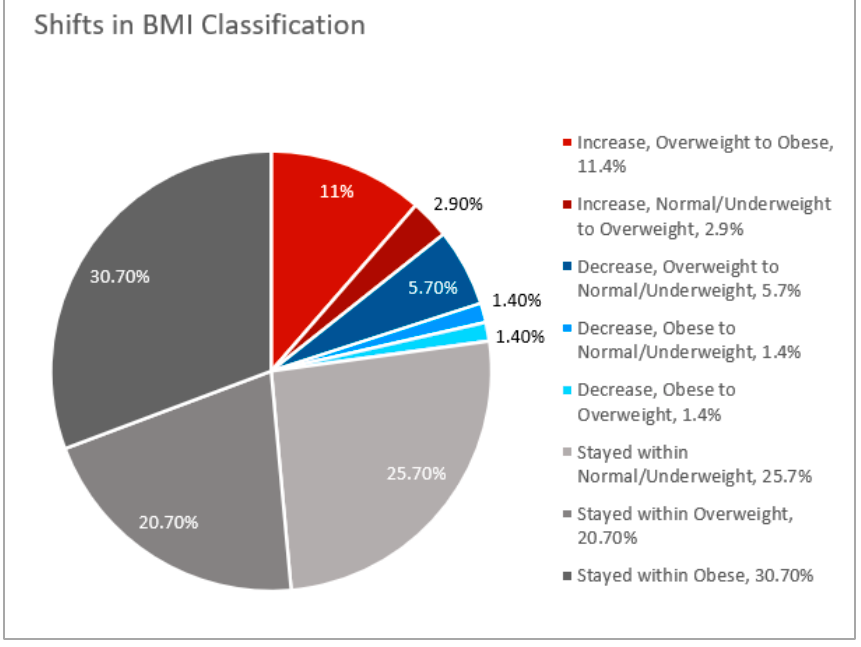
Figure 5. Shifts in BMI classification from date of diagnosis to most recent follow-up.